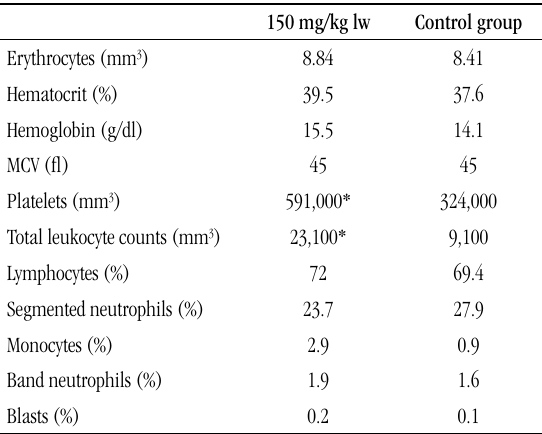
tABLE – Hematological values of Balb/c mice inoculated with the experimental tumor 4T1 submitted to treatment with oral thalidomide (150 mg/kg